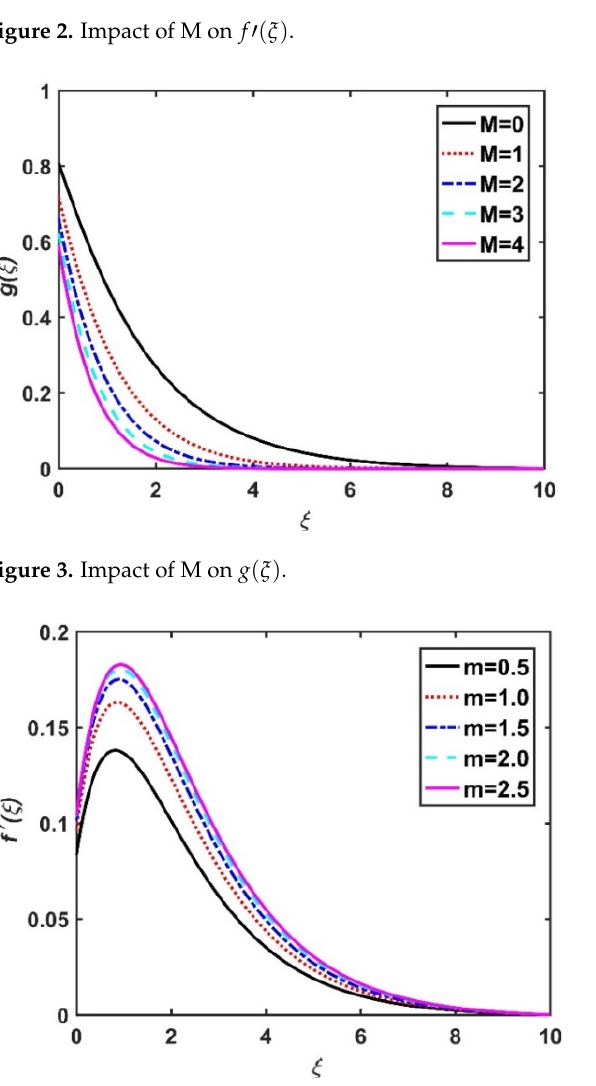
Figure 4. Impact of m on 𝑓′(cid:4666)𝜉(cid:4667) .